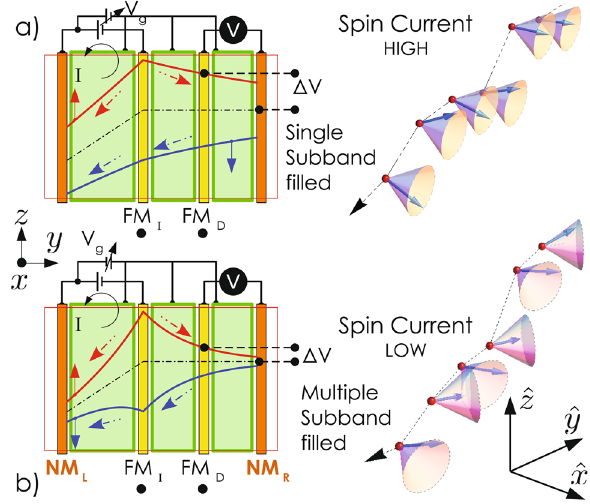
Figure 5. Schematic depiction of the variation of the spin-up (red curve), spin-down (blue curve), and average (dashed black curve) chemical potentials across the channel of the proposed spin-transistor. Broken arrows show the component of spin-resolved charge current. Red (blue) solid arrows represent + ( − ) x spin states. The green pads stand for the gate electrodes. When a single subband is filled, electron spin always precesses about ˆ x (+ or −) direction irrespective of any change in the direction of k (cid:31) due to scattering. On the other hand, when multiple subbands are filled, each scattering event results in a change in k (cid:31) that alters the direction of effective magnetic field and hence the spin precession